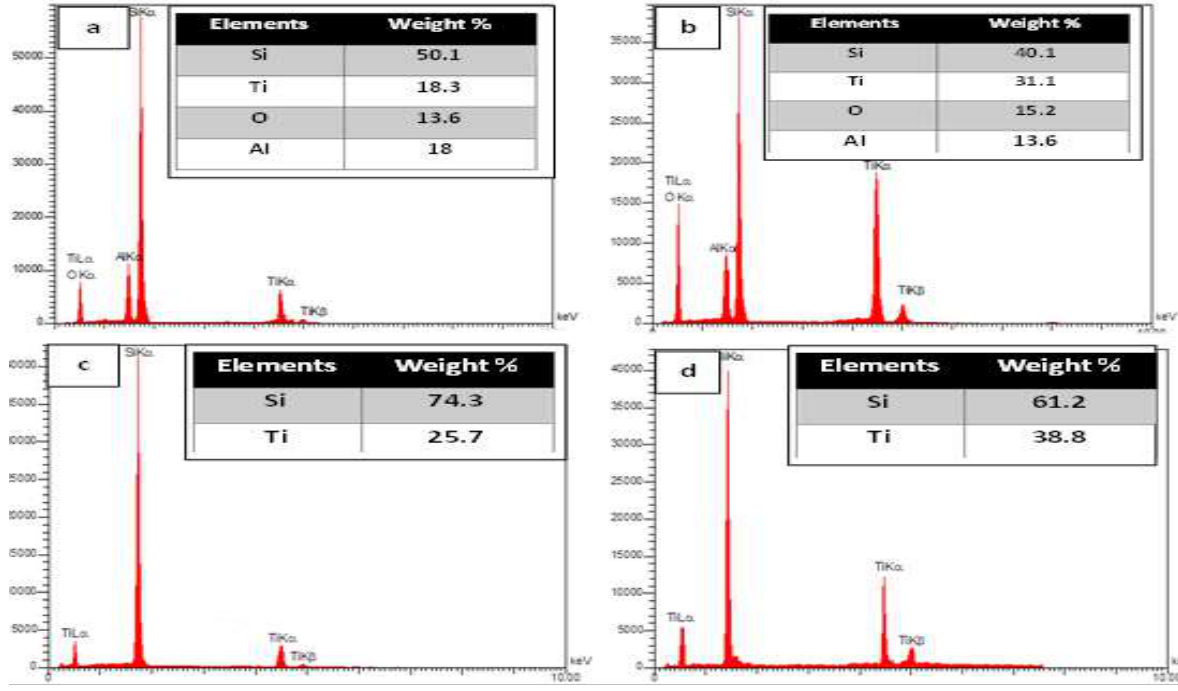
Figure 4: EDX of Ti nanoparticles at 5&10 min (a,b) on glass substrate and (c,d) on Si (n-type).